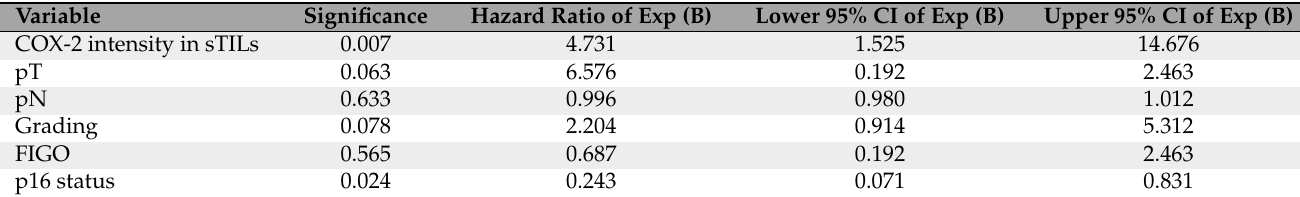
Table 2. Cox regression of clinical–pathological variables regarding long-term overall survival after 10 years in VSCC